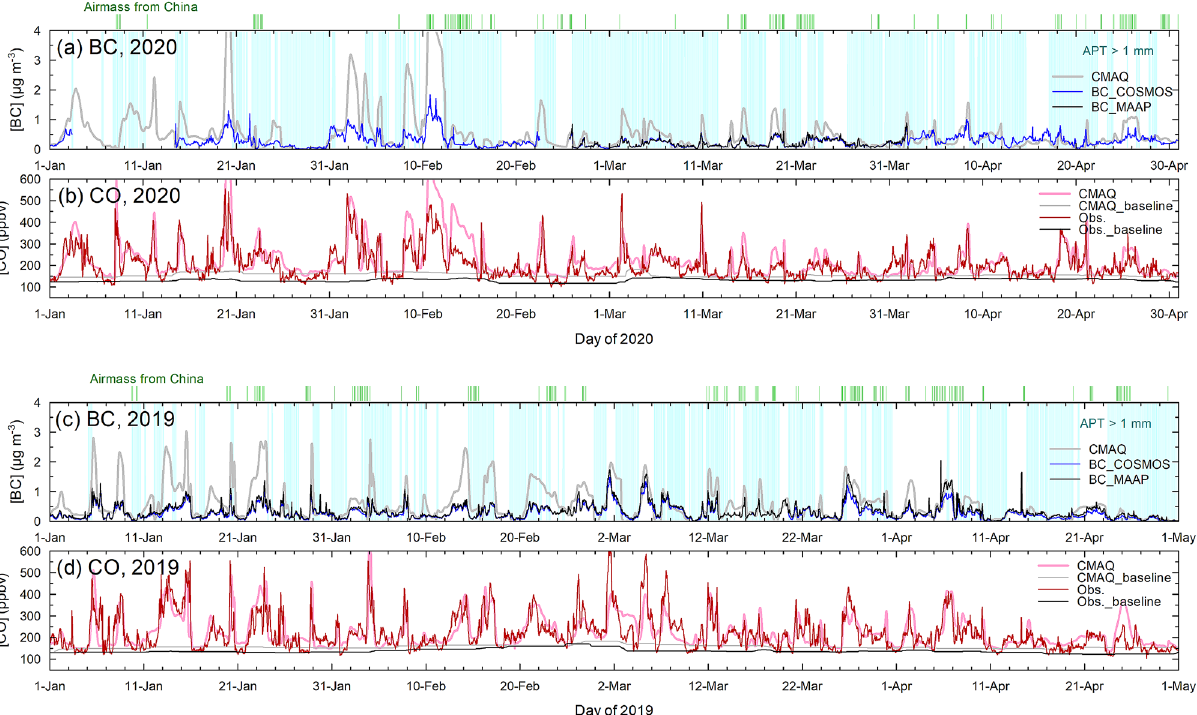
Figure 2. Time series of ( a ) BC mass concentrations and ( b ) CO mixing ratios from observations (dark colors) and model simulations (light colors) during Jan–Apr in 2020 and 2019 ( c , d ). The estimated baseline levels are also shown. The hours with arrival of air masses from China are indicated with green vertical bars. Note that the cases from China but via Korea are not included to avoid false assignment. Light blue lines indicate cases with non-negligible wet